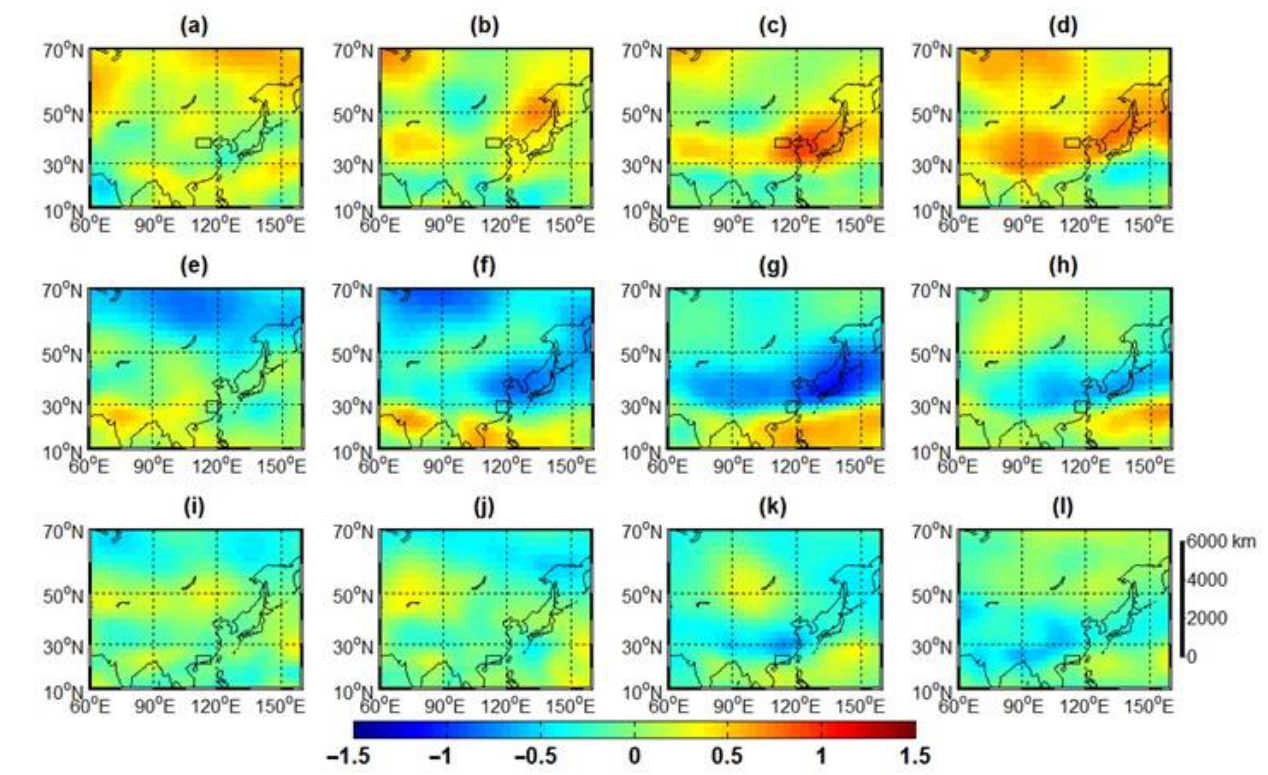
Figure 6. Composite of 500-hPa geopotential-height standardized anomalies for lagged windows of −10 to −6 (first column), −5 to −1 days (second column), 1 to 14 days (third column), and 15 to 21 days (forth column). Each row represents a region (Small black rectangular in the figure), from top to bottom, NC, YRV, and SC. ( a – d ) North China (NC), ( e – h ) Yangtze River Valley (YRV), and ( i – l ) South China (SC).